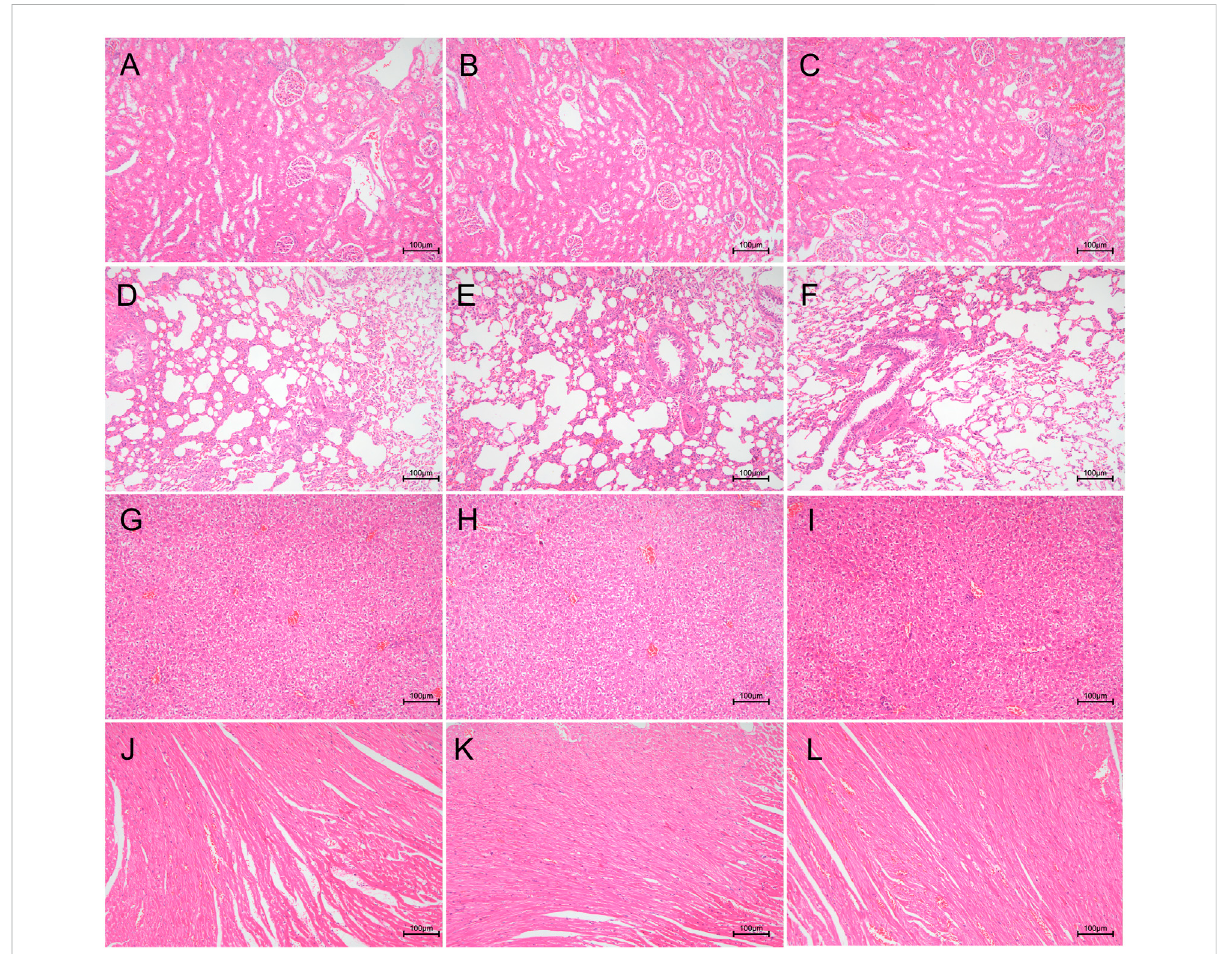
FIGURE 6 Biocompatibilityanalysis of(MMT/HA) 10 and(MMT/HA-RFP) 10 multilamellar fi lms.H&E stainingofratkidney,lung,liver,andheart. (A – C) Kidney intheunmodi fi ed,(MMT/HA) 10 ,and(MMT/HA-RFP) 10 groups,respectively. (D – F) Lungintheunmodi fi ed,(MMT/HA) 10 ,and(MMT/HA-RFP) 10 groups, respectively. (G – I) Liver in the unmodi fi ed, (MMT/HA) 10 , and (MMT/HA-RFP) 10 groups, respectively. (J – L) Heart in the unmodi fi ed, (MMT/HA) 10 , and (MMT/HA-RFP) 10 groups,